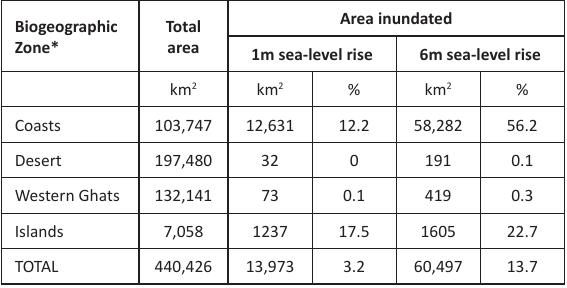
Table 1. Predicted inundation of biogeographic zones of India by marine intrusion as a result of 1m and 6m sea-level rise.